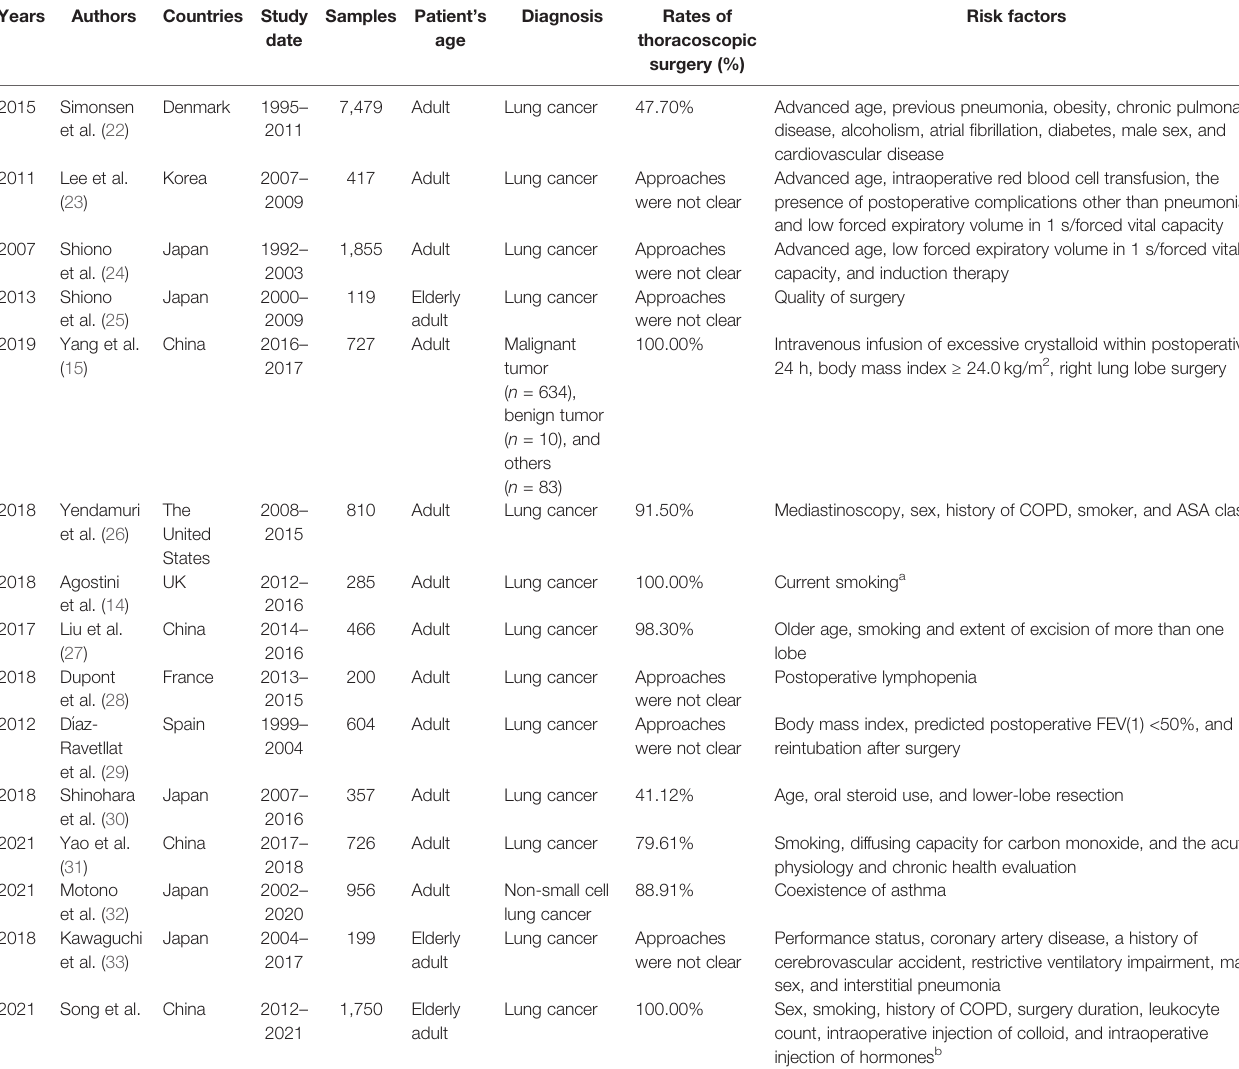
TABLE 6 | A review about recent studies on risk factors for predicting postoperative pneumonia among lung cancer